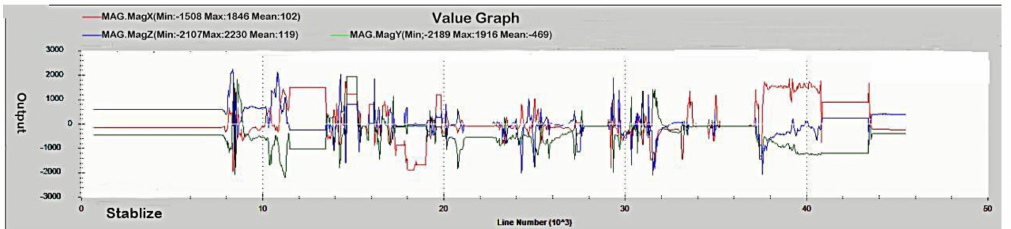
Figure 4. The interference of magnetic field was large, and the UAV was placed in the normal magnetic field environment. A magnet with Gauss on the surface of 0.3 (Tesla) was held. The magnet was close to the UAV, making the environment one of strong magnetic field interference. This is the graph of the magnetometer data collected at this time. The curve in the graph is the sampling point curve, where the unit of the vertical axis is degree. And we can see the sampling data fluctuates